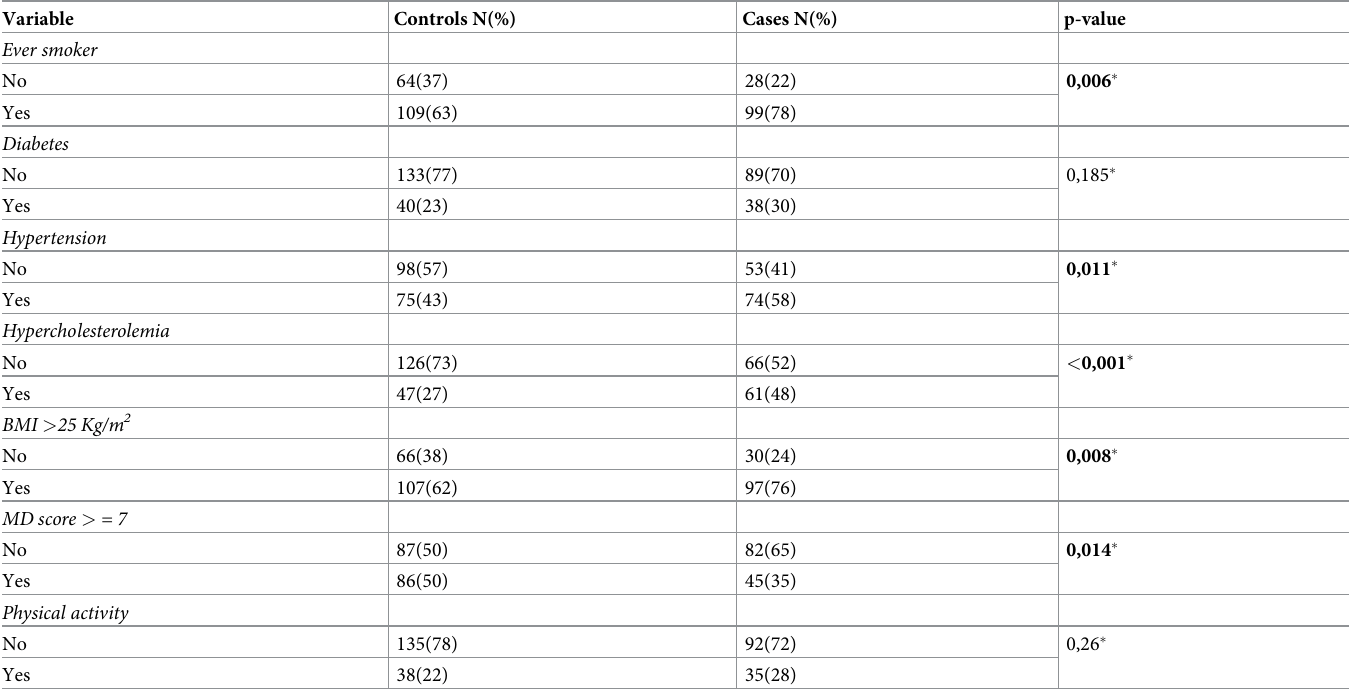
Table 2. Differences in risk factors between cases and